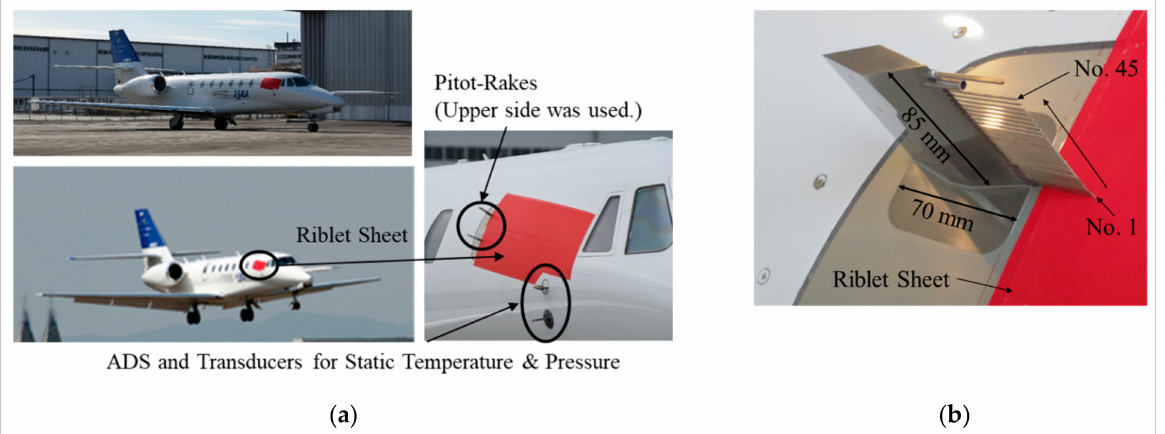
Figure 1. The JAXA flight-test bed and paint-based riblet surface attached to the aircraft: ( a ) Flight-test bed; ( b ) mounted pitot